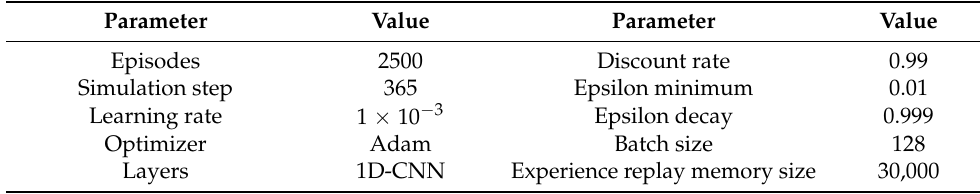
Table 2. List of hyperparameters and